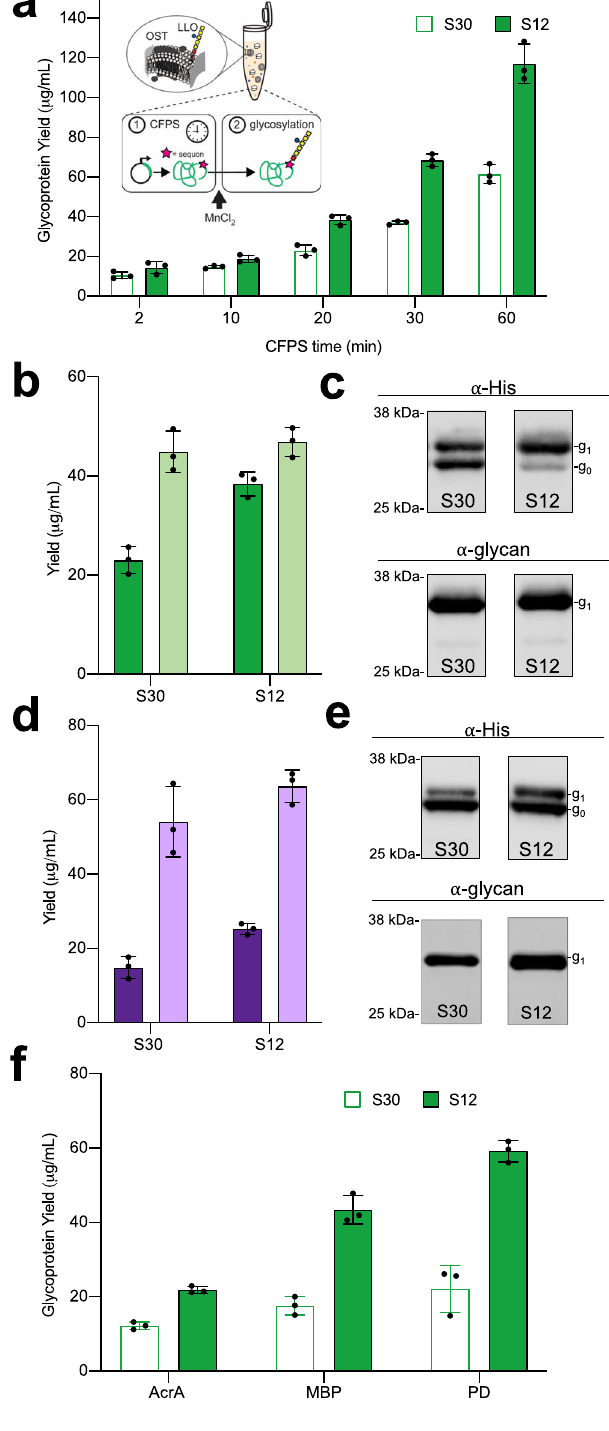
Fig. 5 Increasing vesicle concentrations improves cell-free glycoprotein synthesis (CFGpS) for N - and O -linked glycosylation systems. For panels ( a – e ), a standard curve correlating protein yields derived from 14 C-leucine counting and sfGFP fl uorescence was used to measure total protein concentrations. Quantitative western blotting was used to measure fraction of glycosylated protein. For panel ( f ), protein concentrations were measured using 14 C-leucine incorporation. Fraction of glycosylated protein was measured using autoradiography. a sfGFP glycoprotein yields of CFGpS reactions charged with S12 (green) or S30 (white) extracts enriched with PglB and C. jejuni LLO. Data are presented as mean ± SD of n = 3 biologically independent CFGpS reactions. (Inset) Schematic of two-phase CFGpS reactions. b Glycosylated (dark green) and total (light green) sfGFP yields of N -linked CFGpS reactions with 20 min CFPS times. Data are presented as mean ± SD of n = 3 biologically independent CFGpS reactions. c Anti-His and anti-glycan western blots of acceptor proteins from representative reactions in ( b ) show glycosylated (g1) and aglycosylated (g0) protein. Full western blot images are available in Supplementary Fig. 9A – D and Source Data fi le. d Glycosylated (dark purple) and total (light purple) sfGFP yields from O -linked CFGpS reactions with 20 min CFPS times. Data are presented as mean ± SD of n = 3 biologically independent CFGpS reactions. e Anti-His and anti-glycan western blots of acceptor proteins from representative reactions in ( d ) show glycosylated (g1) and aglycosylated (g0) protein. Full western blot images are available in Supplementary Fig. 12A, B and Source Data fi le. f Glycoprotein yields of AcrA, MBP, and PD produced in CFGpS reactions charged with S12 (green) or S30 (white) extracts enriched with PglB and C. jejuni LLO. Glycoprotein yields of AcrA, which contains 2 internal glycosylation sites, include singly and doubly glycosylated protein. Data are presented as mean ± SD of n = 3 biologically independent CFGpS reactions. Source data for all panels are provided as a Source Data fi